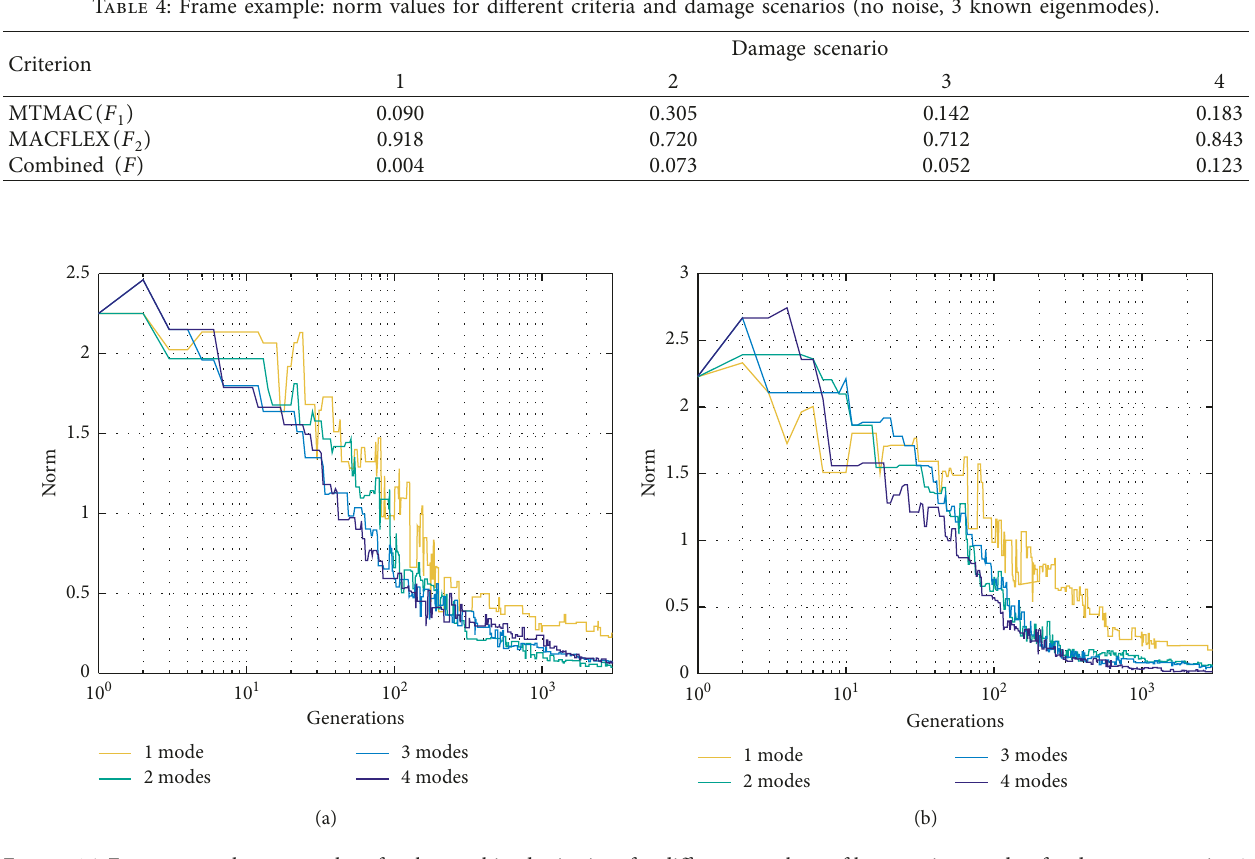
Figure 16: Frame example: norm values for the combined criterion, for different numbers of known eigenmodes, for damage scenarios 2 and 3 (no noise). (a) Scenario 2 and (b) scenario